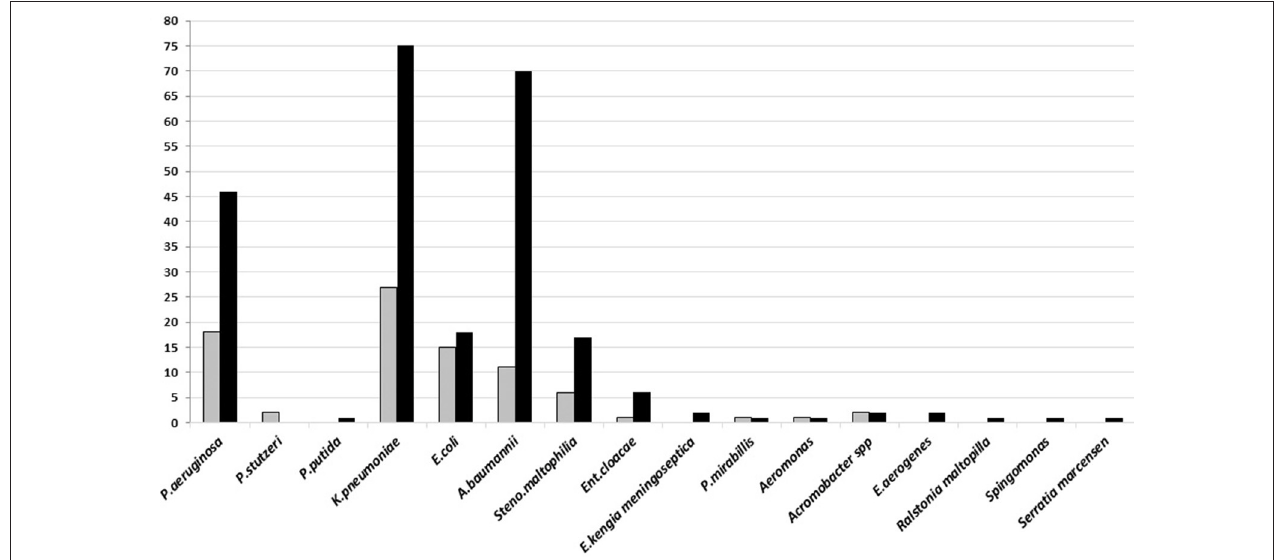
FIGURE 3 | The number of Gram-negative bacteria isolated on sputum culture from January to June 2018 in Tertiary Sanglah Referral Hospital in Bali, Indonesia. Gray and filled boxes are poor and good-quality sputum,